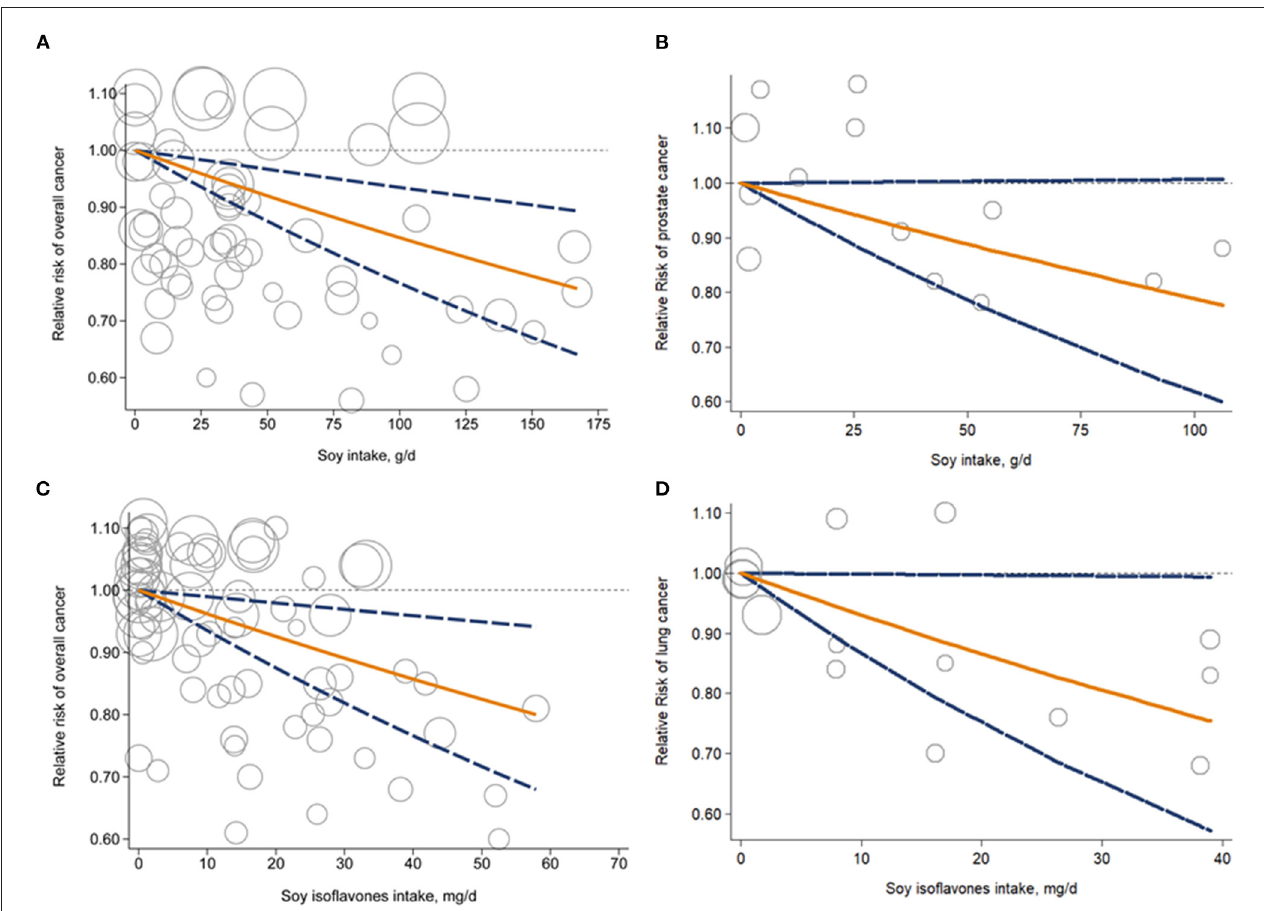
FIGURE 3 | Dose-response analysis for liner association of soy intake with overall cancer risk (A) and prostate cancer risk (B) ; soy isoflavones intake and overall cancer risk (C) and lung cancer risk (D) . Circles represent point estimates plotted over precision measures. Solid lines represent summary RRs; dashed lines are the corresponding 95%CIs. CI, confidence interval; RR, relative